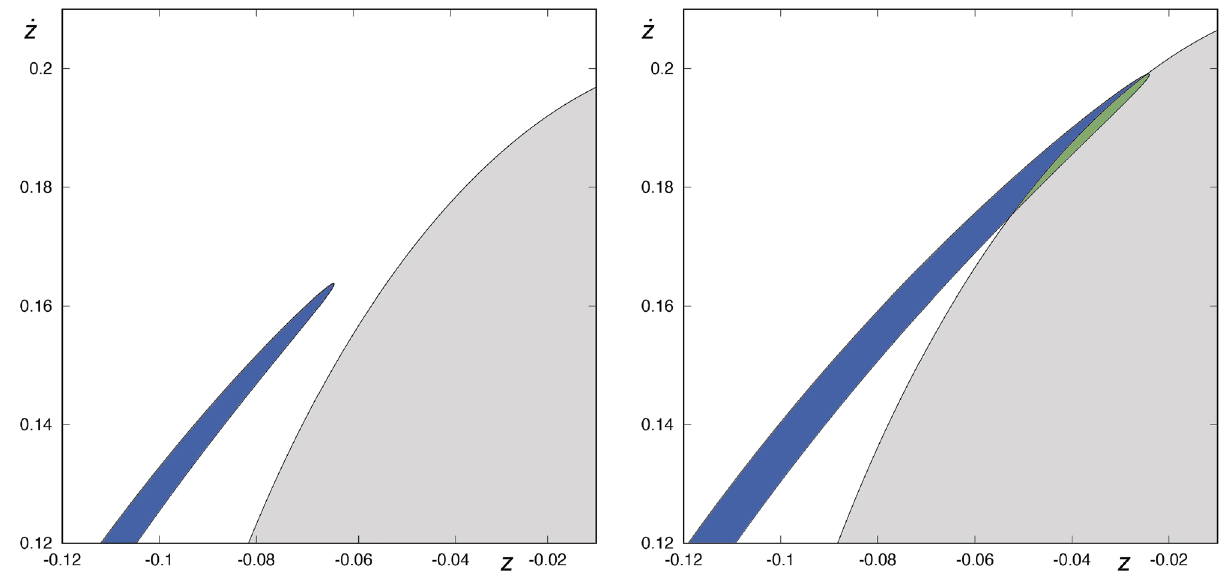
Figure 8. Tip of one of the tongues belonging to W s ,4 (φ) , for H = 0.347 (left panel) and H = 0.35 (right panel). The area enclosed by W s ,4 (φ) is colored in green or blue, depending on whether it is contained in the area enclosed by W u ,1 (φ) or not, respectively. This graphic has been generated by using Gnuplot Version 5.2. http:// www. gnupl ot.